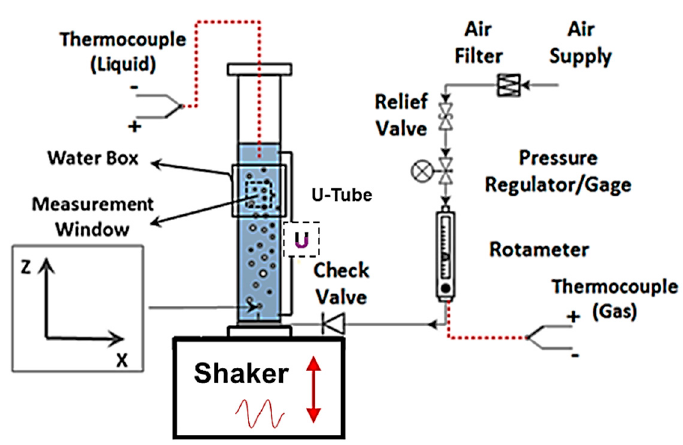
Figure 2. Schematic of the experimental setup.